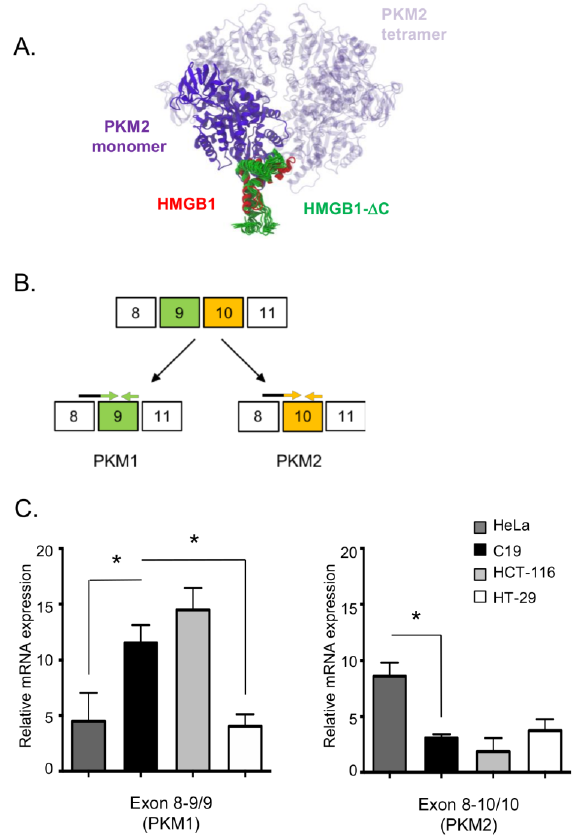
Figure 5. ( A ) In silico HMGB1- ∆ C–PKM2 docking. Complexes were obtained after 40,000 simulations of diffusional association (SDA). The most favorable solutions were obtained after clustering and energy calculations. The PKM2 monomer considered in our calculations is colored purple while the other subunits are represented in high transparency. The lowest energy docking solution obtained for native HMGB1 is represented in red and the solutions obtained for HMGB1- ∆ C are shown in green. ( B ) Schematic PKM-spliced isoforms. PKM gene encodes for two isoforms, PKM1 and PKM2. PKM1 only contains exon 9 (exon 10 is excised), whereas PKM2 only contains exon 10 (exon 9 is excised). Forward primers overlapping the exons 8–9 (PKM1) or the exons 8–10 (PKM2) junctions are shown in black/green and black/orange, respectively. Reverse primers specific to exon 9 or exon 10 are shown in green and orange, respectively. ( C ) Splicing pattern of PKM gene in HeLa, C19, HCT-116 and HT-29 cells. Transcript expression levels were measured by real-time PCR relative and fold changes calculation performed by using the 2 − ∆∆ CT method. The mRNA expression levels of the housekeeping gene L19 and of the constitutive exon2 of PKM1/2 were used for normalization. Data are expressed as mean ± SD. p values were calculated using the Student’s paired t test. * p <